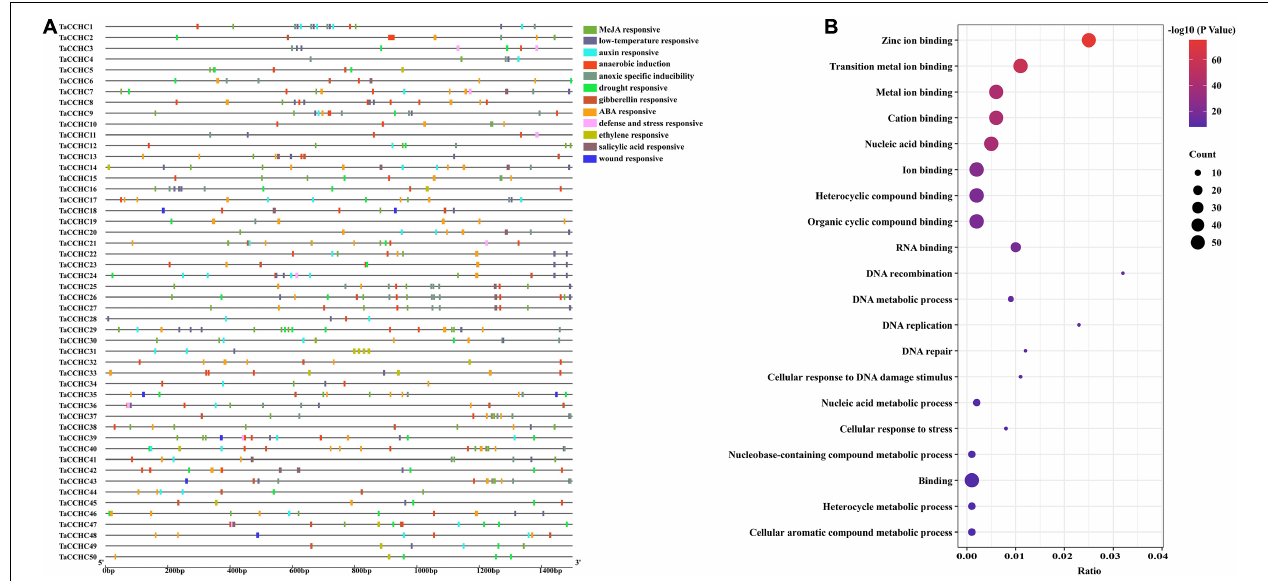
FIGURE 7 | Analyses of cis -acting elements and functional annotation of TaCCHC-ZFP genes. (A) Distribution of predicted cis -acting elements in the promoter regions of TaCCHC-ZFP genes. The color blockers indicate different cis -acting elements and their locations in these TaCCHC-ZFP genes. (B) GO enrichment analysis of the TaCCHC-ZFP